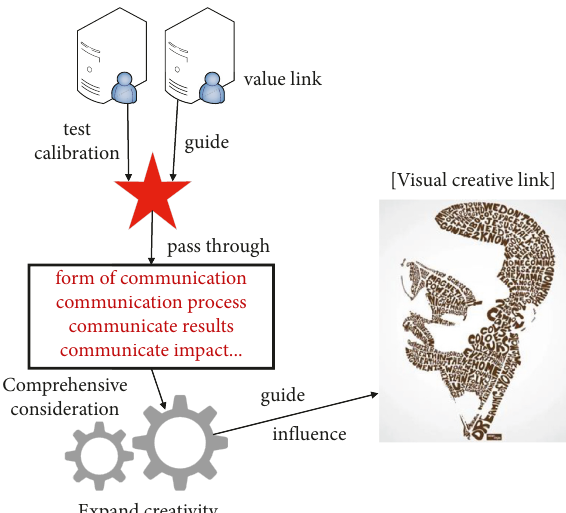
Figure 3: Logical structure diagram of creative integrated links.